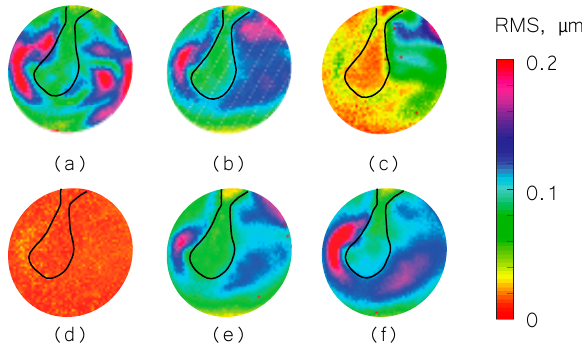
Figure 5. RMS of TB4 displacement under different conditions. ( a ) Open cavity; ( b ) closed cavity; ( c ) half fluid in contact; ( d ) full fluid in contact; ( e ) stapes immobilization; and ( f ) IS joint interruption.